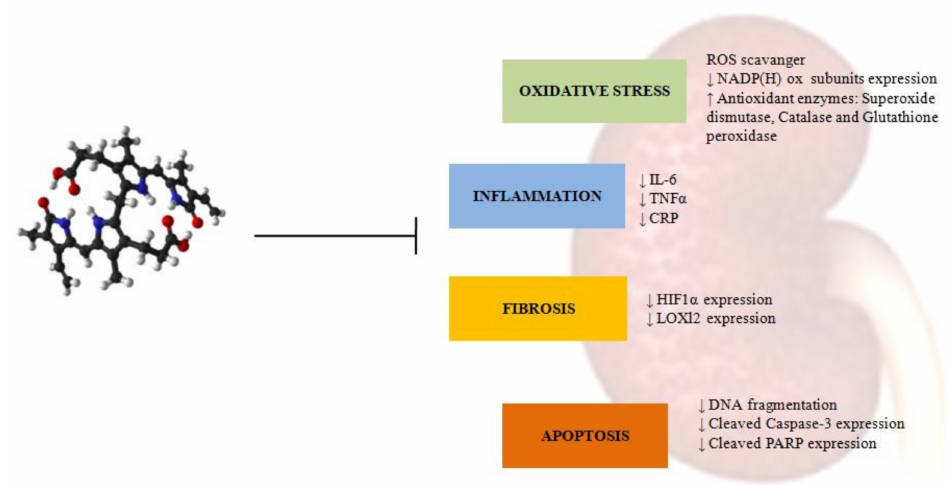
Figure 2. Bilirubin protective effect on mechanisms leading to in diabetic kidney disease. ROS: reactive oxygen species; NADPH: nicotinamide adenine dinucleotide phosphate reduced form; IL-6: interleukin-6; TNF α : tumor necrosis factor alpha; CRP: C-reactive protein; HIF1 α : hypoxia inducible factor 1, alpha subunit; LOXl2: lysyl oxidase like 2; DNA: deoxyribonucleic acid; PARP: nuclear poly ADP ribose